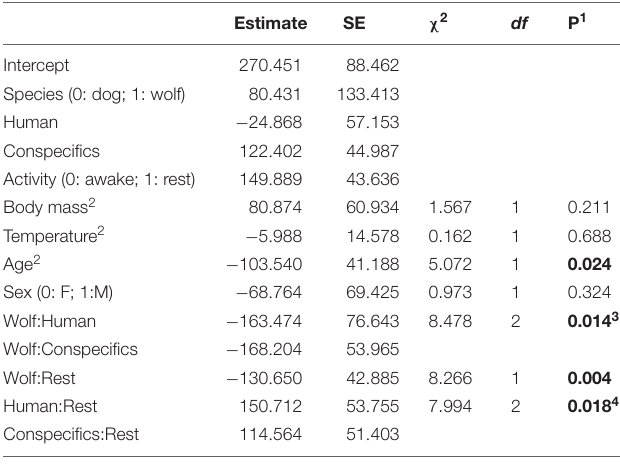
TABLE 4 | Results for the HRV